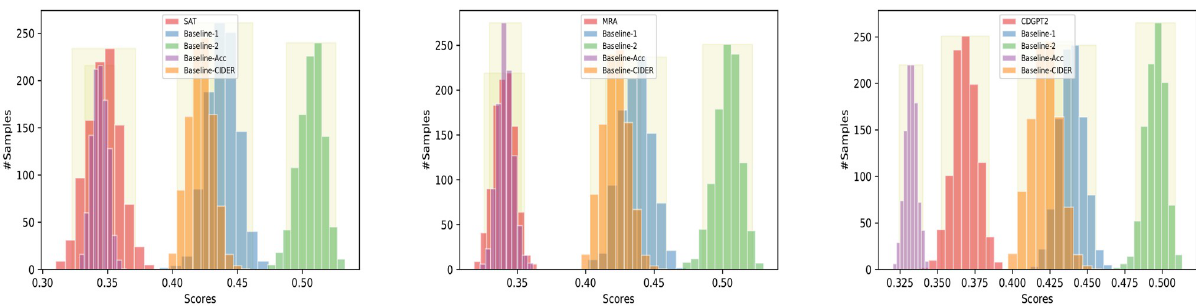
Fig 8. Bootstrap distributions of BLEU-1 values for various pairs of methods. 95% confidence intervals are shown in light yellow color.